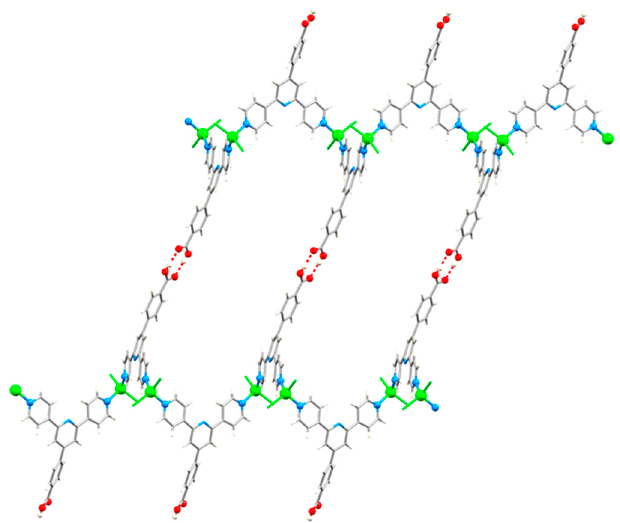
Figure 14. Hydrogen ‐ bonded polymer chains in [Zn 2 (H 17 ) 2 Cl 4 ] n . 2 n EtOH . n H 2 O associate into a 2D ‐ sheet (CSD refcode DIRMEY).